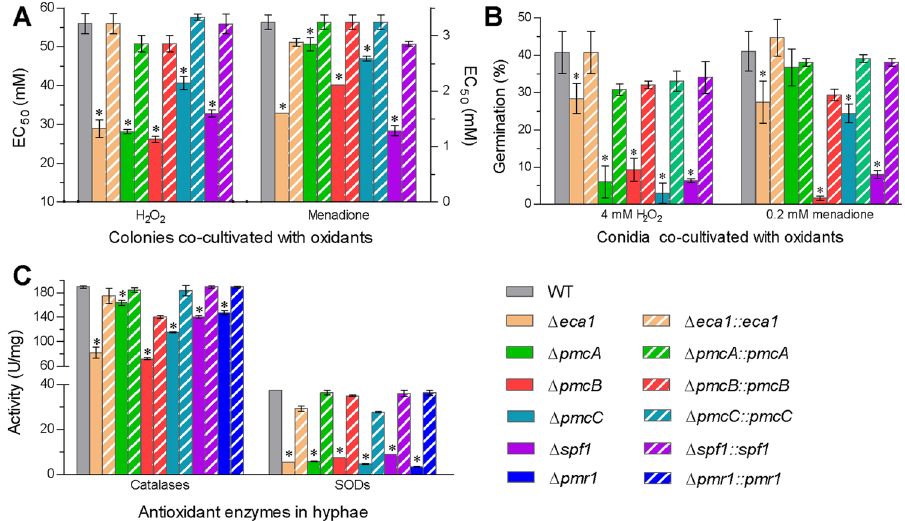
Figure 5. The CA pumps sustaining antioxidant activity in B . bassiana . ( A ) EC 50 s for H 2 O 2 and menadione to suppress 50% growth of fungal colonies after 6 days of incubation at 25 °C on 1/4 SDAY plates, on which hyphal mass discs (5 mm diameter) were attached for colony initiation. ( B ) Germination percentages of fresh conidia after 24 h co-cultivation with H 2 O 2 and menadione on a germination medium at 25 °C. ( C ) Total activities of SODs and catalases quantified from the protein extracts of 3-day-old SDAY cultures (hyphal cells). The asterisked bars in each bar group differ significantly from those unmarked (Tukey’s HSD, P < 0.05). Error bars: SD from three